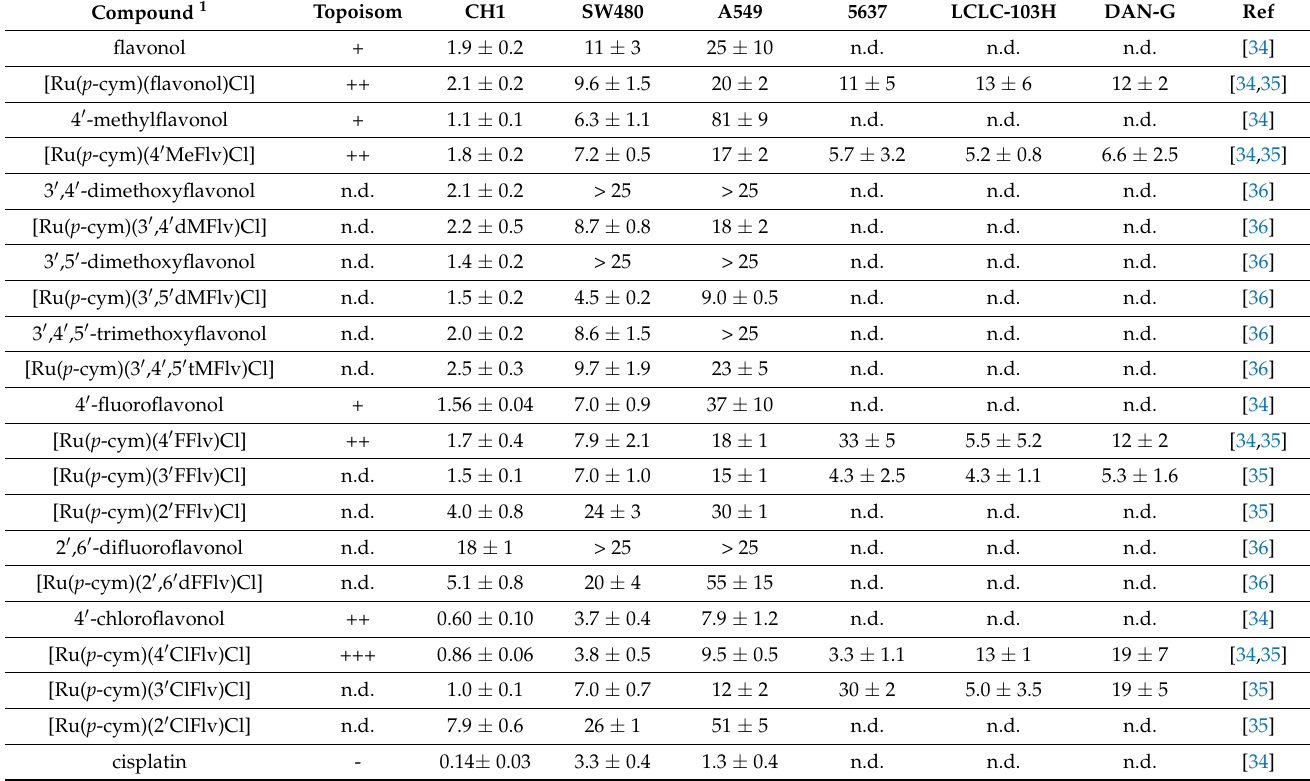
Table 3. Topoisomerase in vitro inhibition and cytotoxicity, expressed by the IC 50 values in µ M (mean ± s.d.) at 96 h of incubation of flavonol derivatives and their corresponding ruthenium p -cymene complexes against human ovarian, colon, non-small cell lung, urinary bladder, large cell lung, and pancreatic carcinoma cell lines. Cisplatin is used as the reference